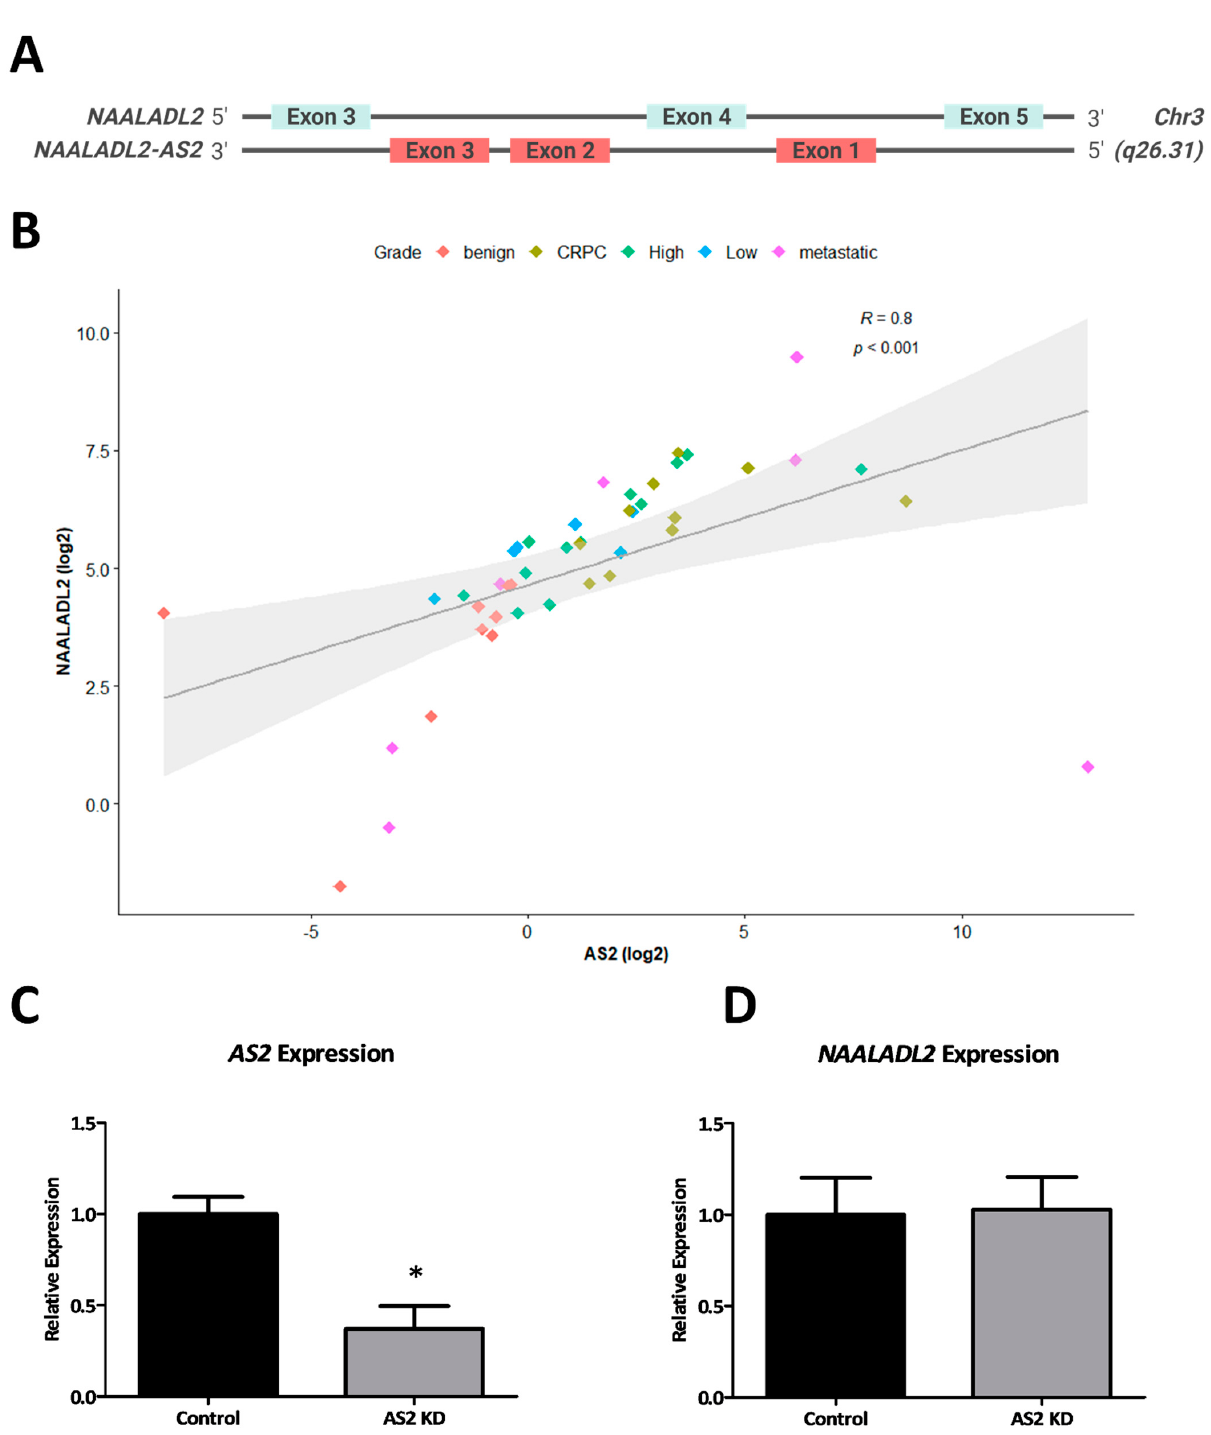
Figure 3. The genomic structures of NAALADL2 and AS2 as interpreted from the UCSC Genome Browser (GRCh38/hg38) (not to scale) ( A ). The expression of AS2 and NAALADL2 in tumor RNA samples measured by qPCR ( n = 44), Spearman correlation ( B ). AS2 and NAALADL2 expression measured by qPCR in LAPC-4 cells cultured with scrambled (control) or AS2-specific GapmeR antisense oligonucleotides (AS2 KD) for 72 h; Pairwise means comparison was done using a T -test, *: p < 0.05 ( n = 3) ( C , D ).